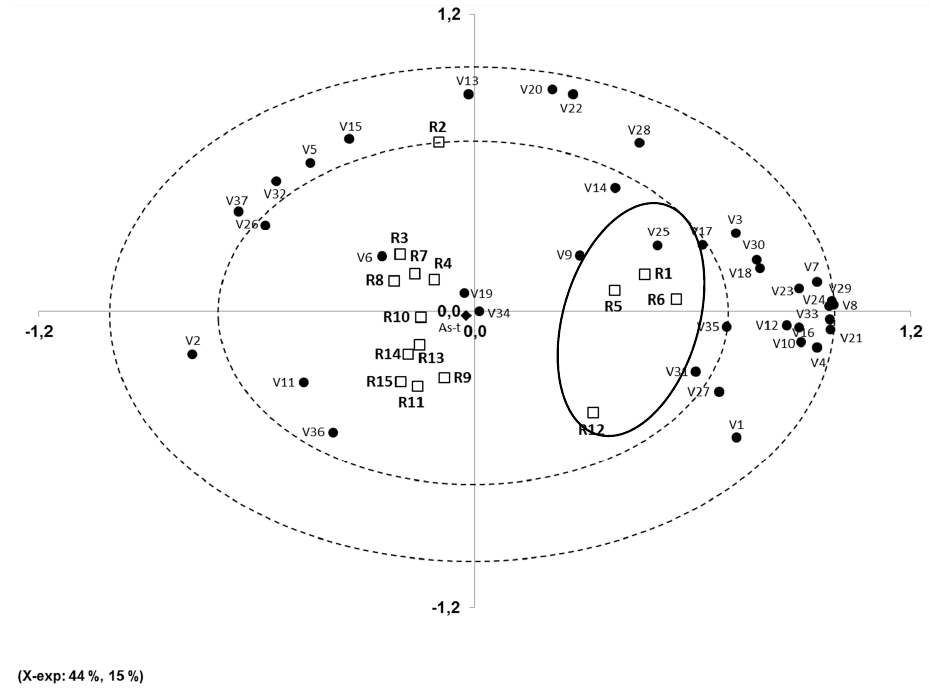
Figure 1. PCA scores plot showing relationship among volatile compounds and rice sample ( ● volatile compound, □ rice sample).